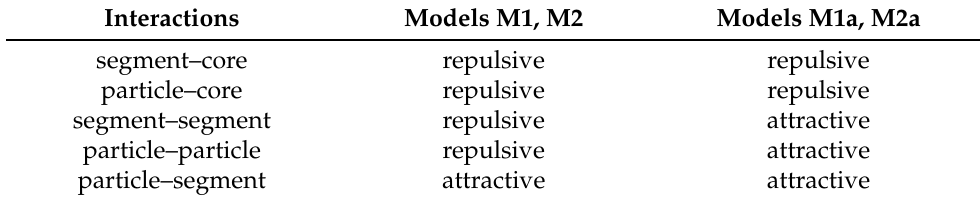
Table 1. Types of interactions in different